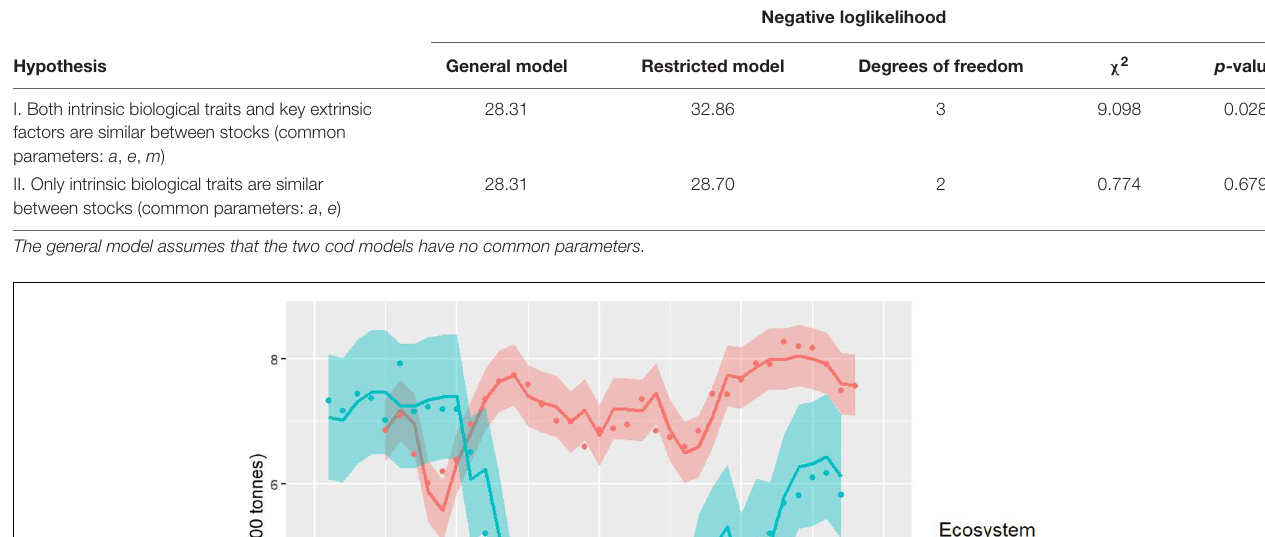
TABLE 2 | Test of hypothesis for common parameters between the NL and BS cod models using likelihood ratio tests.